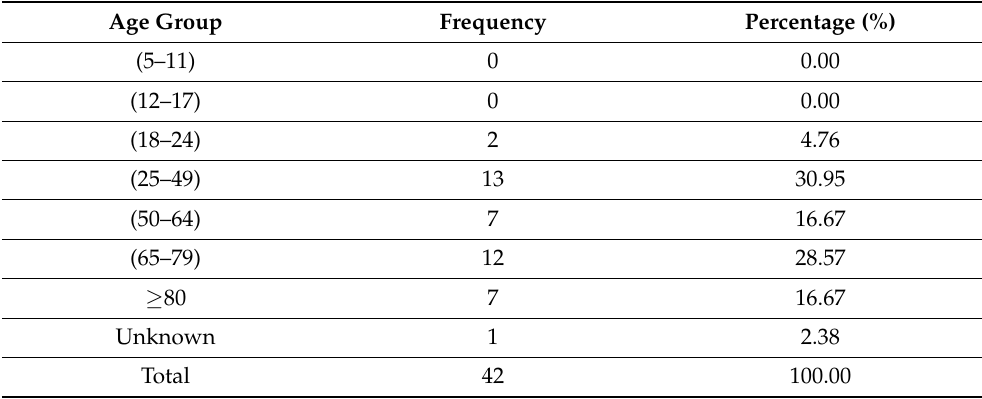
Table 5. Characterization of serious notifications with the seriousness criteria “Hospitalization”, according to the associated age.